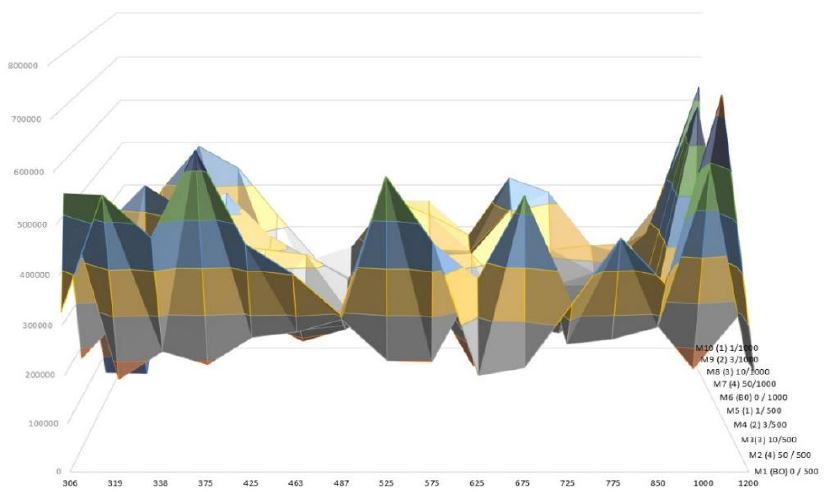
Figure 5. Size distribution of particles measured during the sanding process.